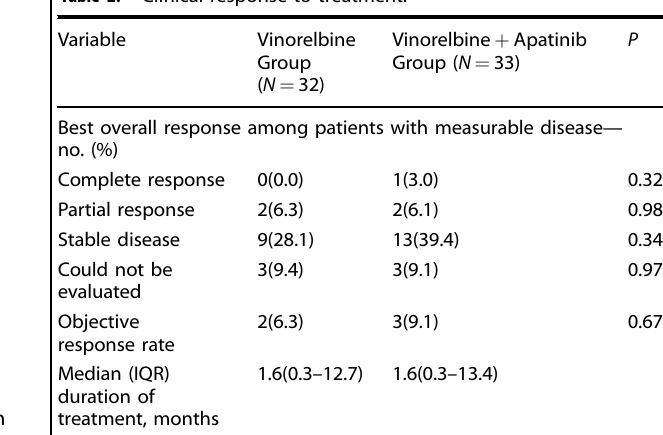
Table 2. Clinical response to treatment.